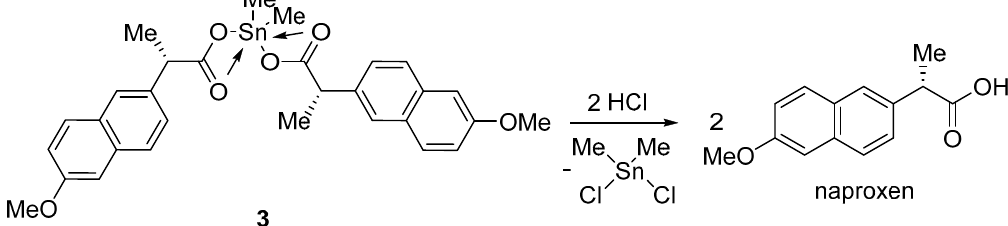
Figure 15. Diorganotin(IV) complex 3 acting as an HCl scavenger.